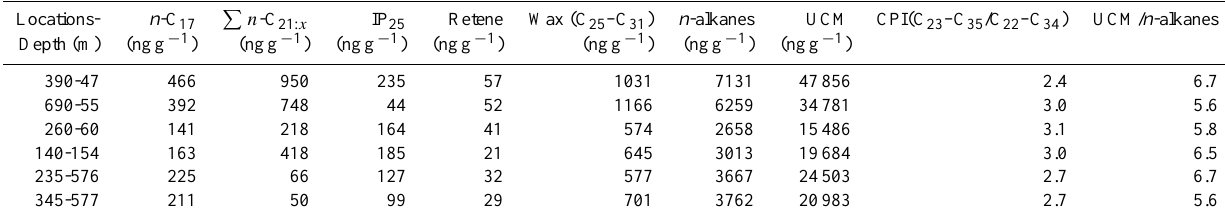
Table 4. Selected hydrocarbon concentrations and diagnostic ratios in sediment samples from the Beaufort Sea